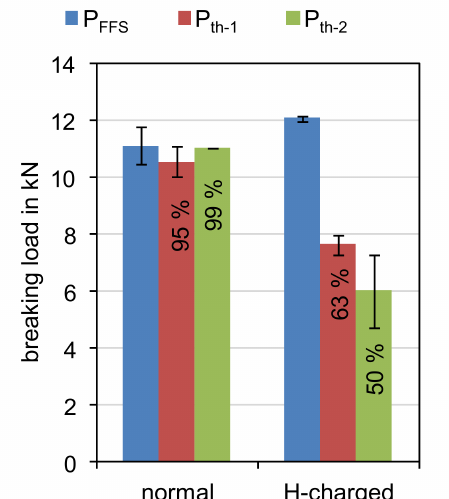
Figure 17. Comparison of the incremental step loading test between the industrial standard (normal) and the H-charged condition; material: 20MnCr5 (III); x ± s, n = 3.